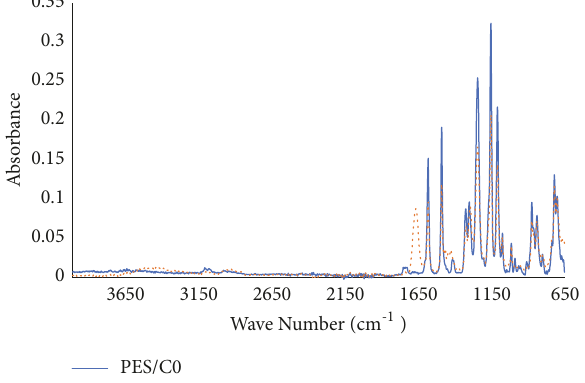
Figure 8: Fourier transform infrared spectrum of